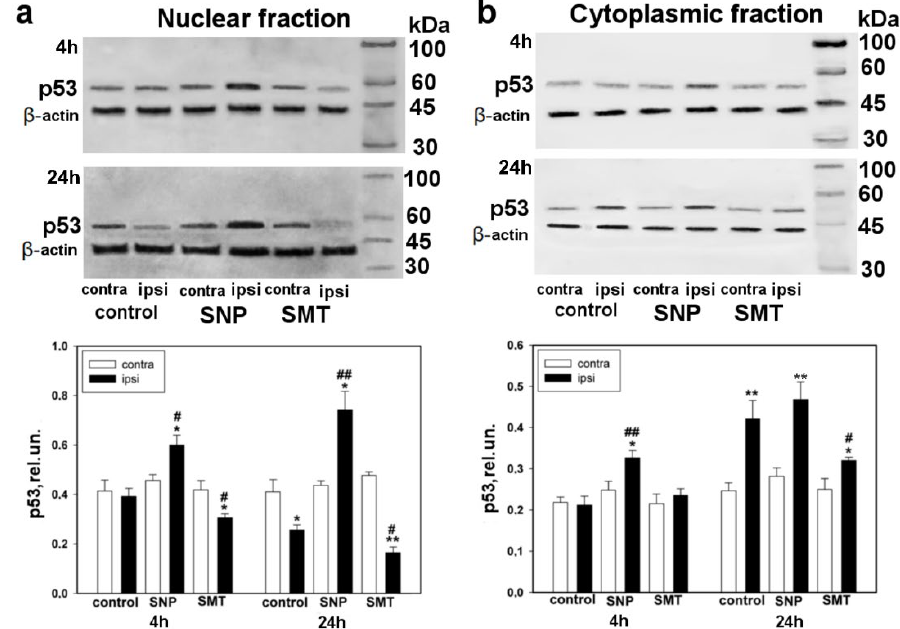
Figure 2. Western blot analysis. The effect of the NO donor (SNP) and the iNOS selective inhibitor (SMT) of p53 expression in the ipsilateral and contralateral DRGs, 4 h and 24 h after sciatic-nerve transection. ( a ) Nuclear fraction; ( b ) cytoplasmic fraction. One-w ay ANOVA. М ean ± SEM. n = 6. * р < 0.05, ** р < 0.01 — ipsilateral DRG with respect to the contralateral DRG of the same animal; # р < 0.05, ## р < 0.01 —ipsilateral DRG with respect to the ipsilateral DRG of the control group animal, within the framework of the same time interval after axotomy.